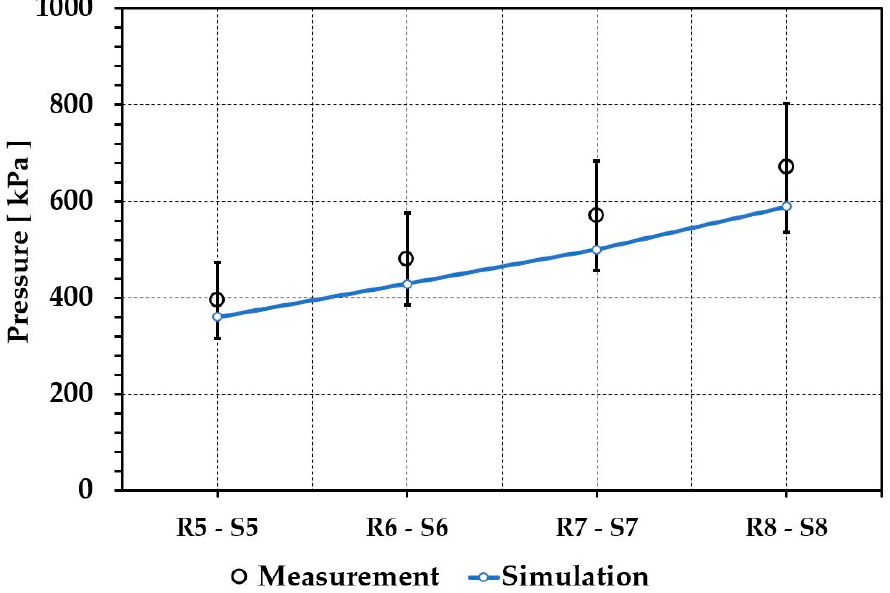
Figure 6. Pressure comparison between measurement and simulation.